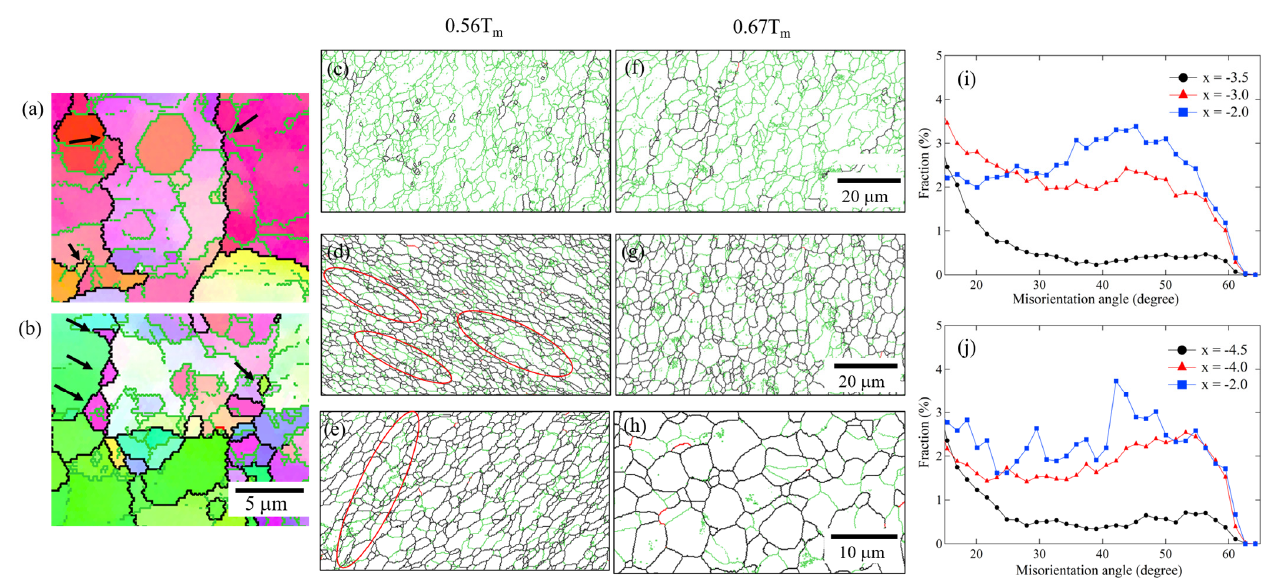
Figure 5. Magnified ( a – b ) IPF maps of Figure 3( b ) at x = − 4.0. Magnified grain boundaries maps at ( c ) x = 3.5, ( d ) x = − 3.0, and ( e ) x = − 2.0 at 0.56 T m ; and ( f ) x = 4.5, ( g ) x = − 4.0, and ( h ) x = − 2.0 at 0.67 T m . Misorientation histograms of the HAB at ( i ) 0.56 T m and ( j ) 0.67 T m .